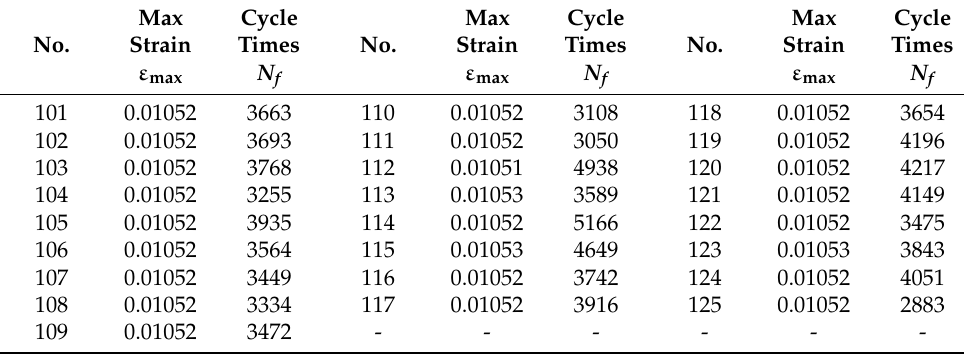
Table A4. Fatigue test data of T = 530 ◦ C, R = 0.05, strain range